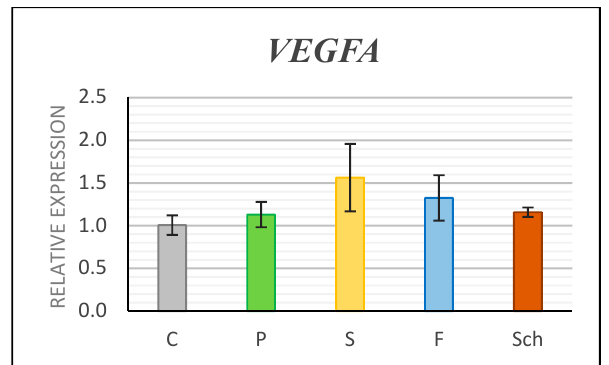
Figure 5. Gene expression of VEGFA as analyzed by QPCR. Control (C), palm oil (P), safflower oil (S), fish oil (F), and Schizochytrium extract (Sch) treated animals were analyzed 12 days after skin excision. Average values and standard deviations are displayed in the graph.